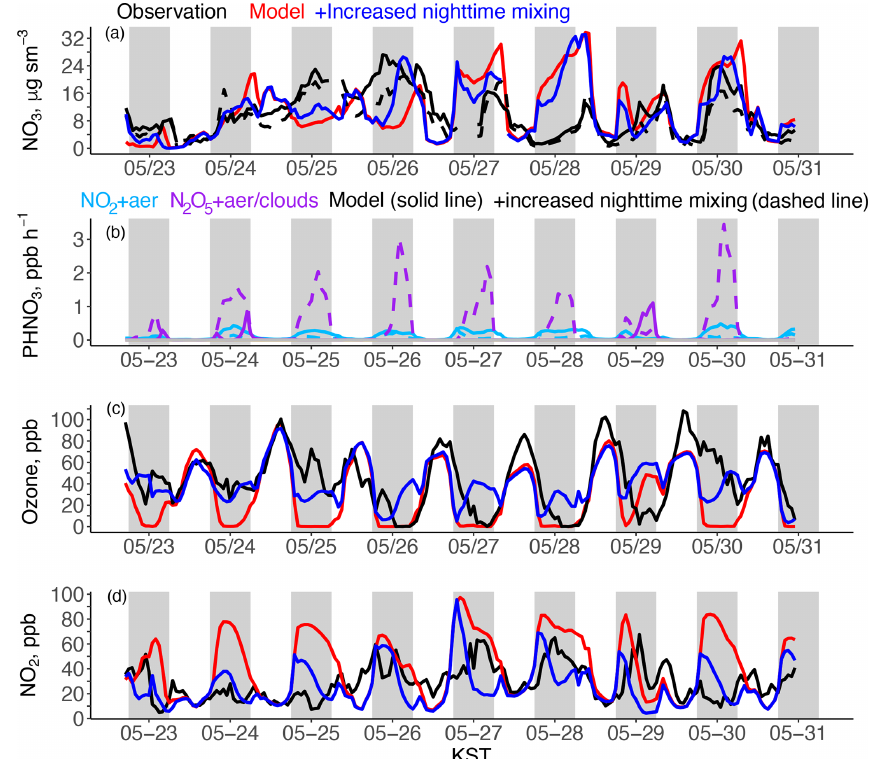
Figure 11. (a) Transport/Haze period time series of modeled and observed hourly nitrate fraction of PM 2 . 5 , (b) modeled production of HNO 3 from N 2 O 5 (Reaction R2) and NO 2 (Reaction R4), (c) ozone, and (d) NO 2 . The sensitivity studies are described in Sect. 6. The gray shaded regions represent 18:00 to